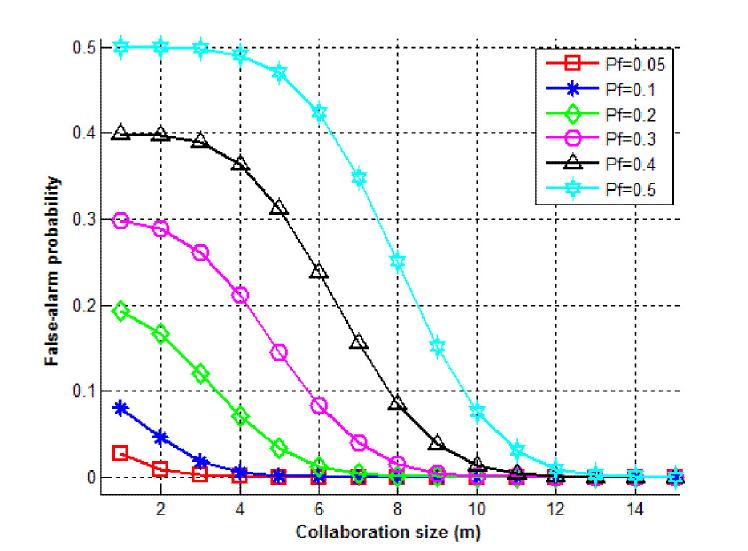
Figure 16. False-alarm probability ( P